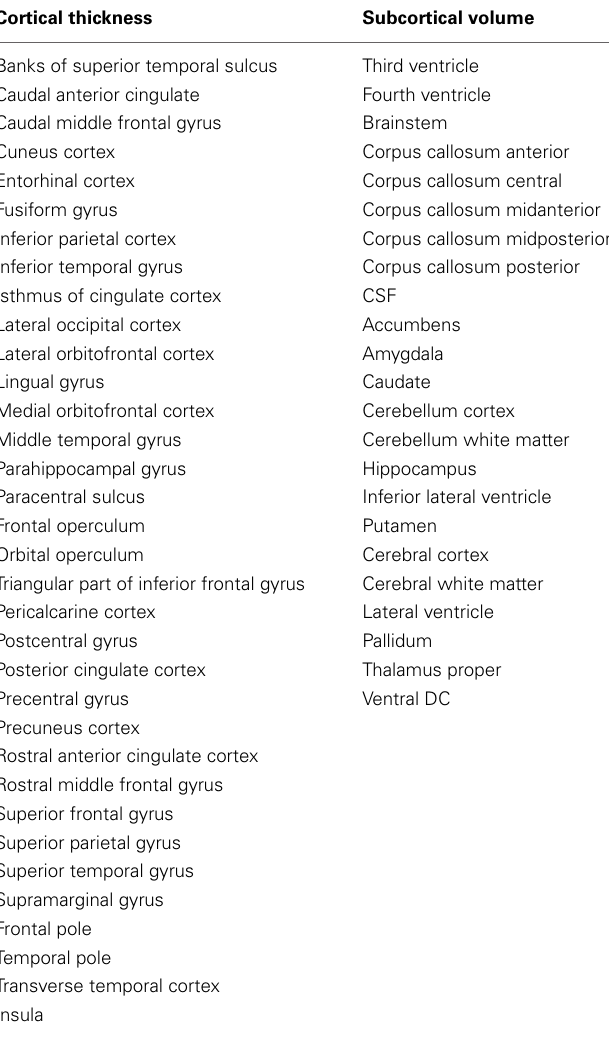
Table 3 | FreeSurfer variables included in the